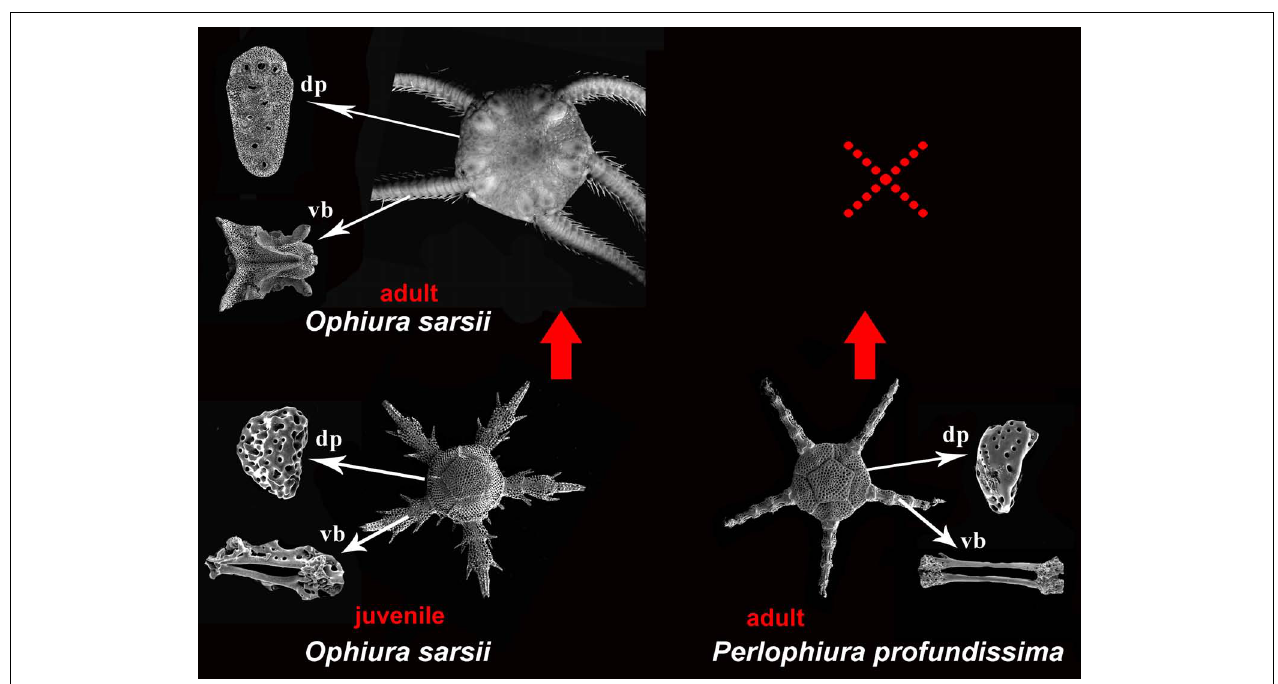
FIGURE 5 | Evidence for essential, unique similarity between respective homologous ophiuroid characters, including external primary disk plates and internal ossicles (dp, dental plate; vb, vertebrae) of the adult strongly paedomorphic ophiuroid Perlophiura profundissima and phylotypic periods of early juveniles (postlarvae) of the complex non-paedomorphic ophiuroid Ophiura sarsii . The considerable reducing of the paedomorphic life cycle, which lacking complex adult stage is indicated by dashed red cross. By this unique similarity between adult paedomorphic taxa and juveniles of the complex taxa makes almost direct ontogenetic-and-evolutionary linkage as impossible to